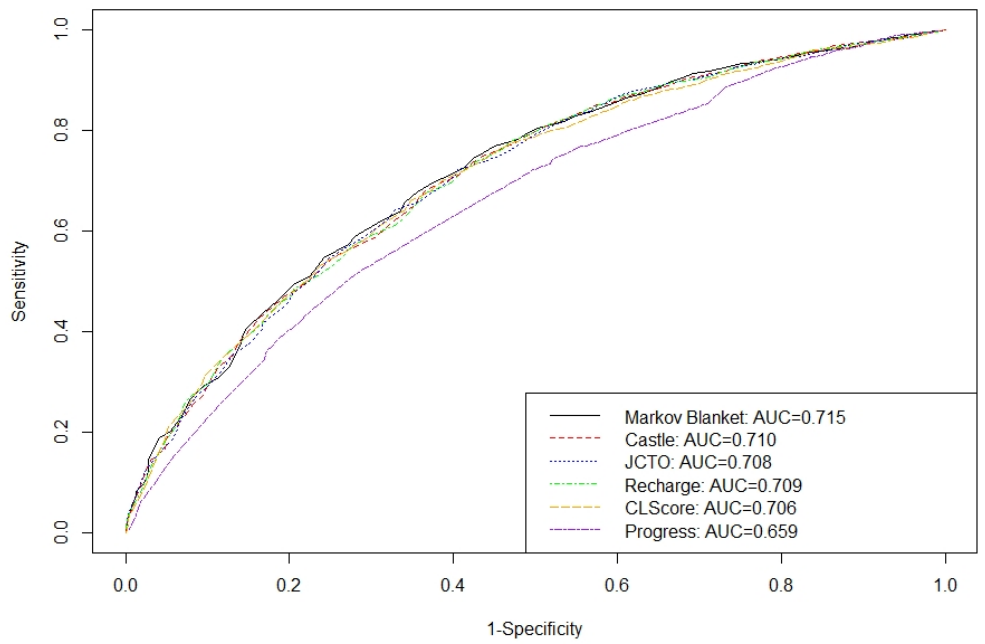
Figure 4. Diagram of the area under the receiver operation characteristics (AUROC) curve of all six models, based on the test dataset ( n = 5210).